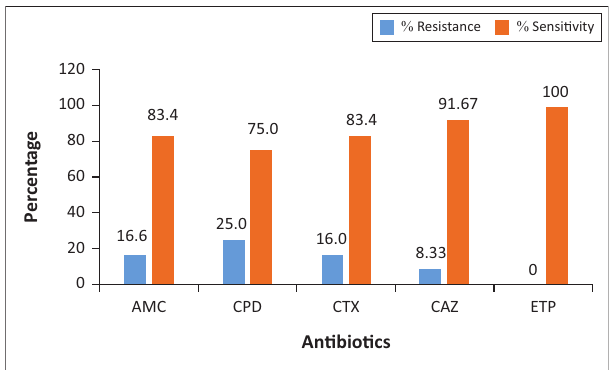
FIGURE 3: Antibiotic sensitivity and resistance pattern for Enterobacteriaceae isolates.